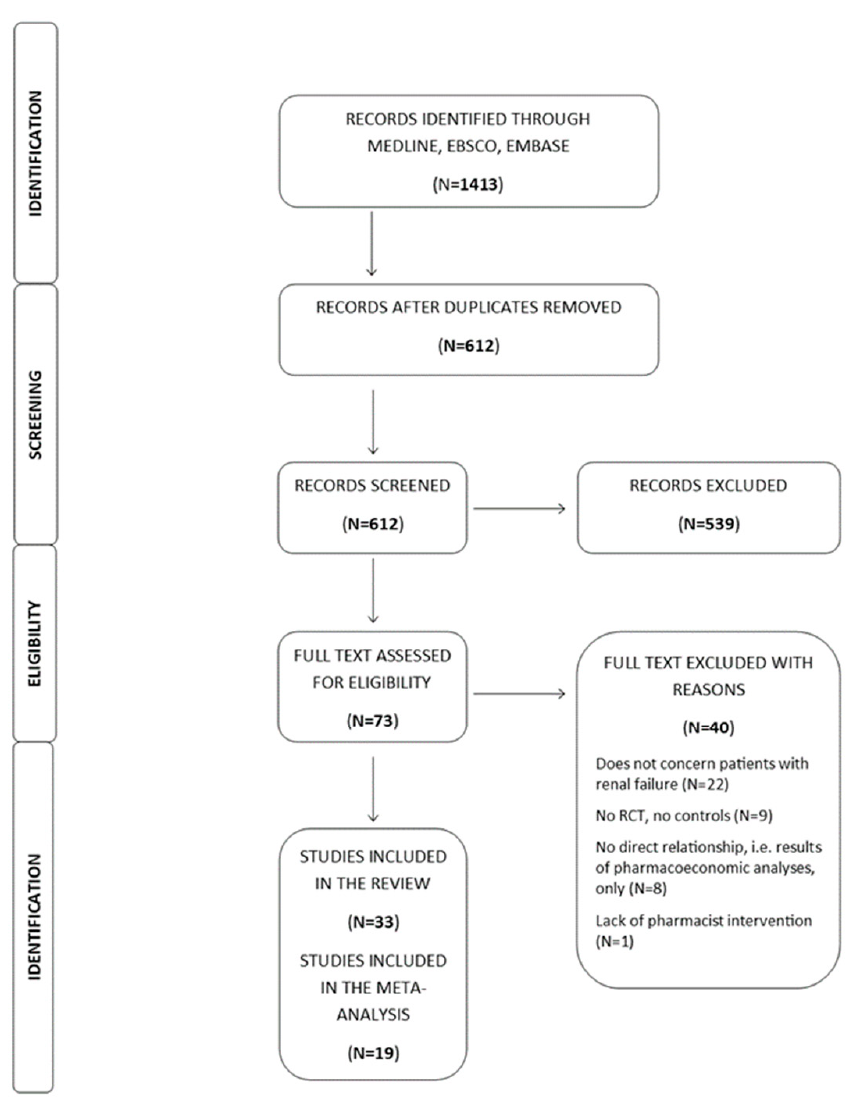
Figure 1. Flow diagram of the search study.